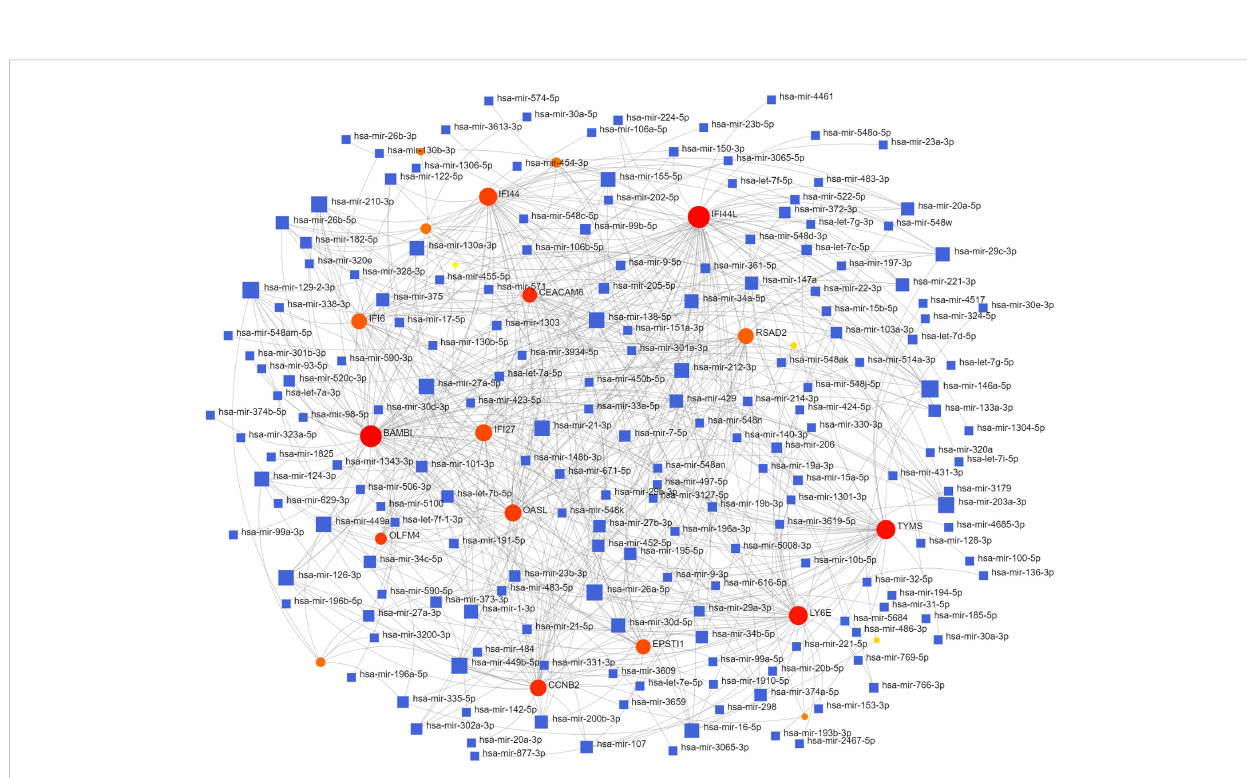
FIGURE 6 The interconnected regulatory interaction network of DEGs –